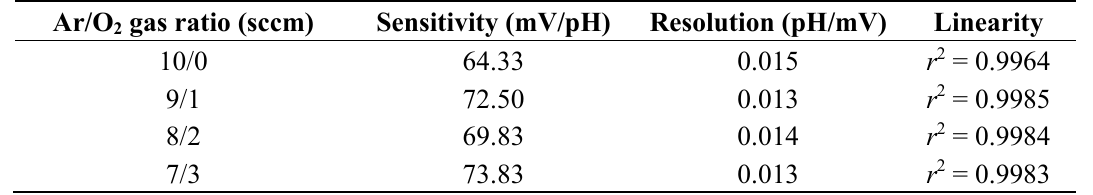
Figure 3. SEM images of the RuO 2 thin-films for Ar/O 2 ratios of ( a ) 10/0; ( b ) 9/1; ( c ) 8/2; ( d ) 7/3; ( e ) different magnification for Ar/O 2 = 8/2. Table 1. pH sensitivity and linearity of RuO 2 sensing film prepared with different Ar/O 2 gas ratio. Ar/O gas ratio 2